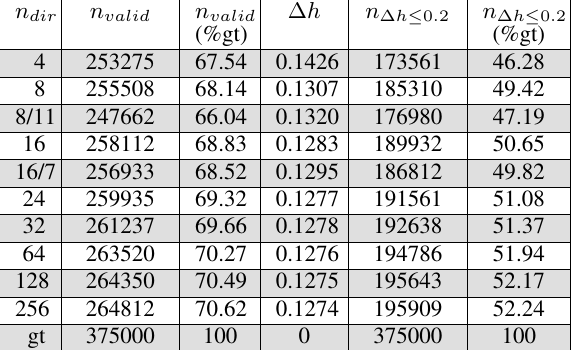
Table 3. Coverage and accuracy for a low-texture cube processed with different numbers of SGM path directions